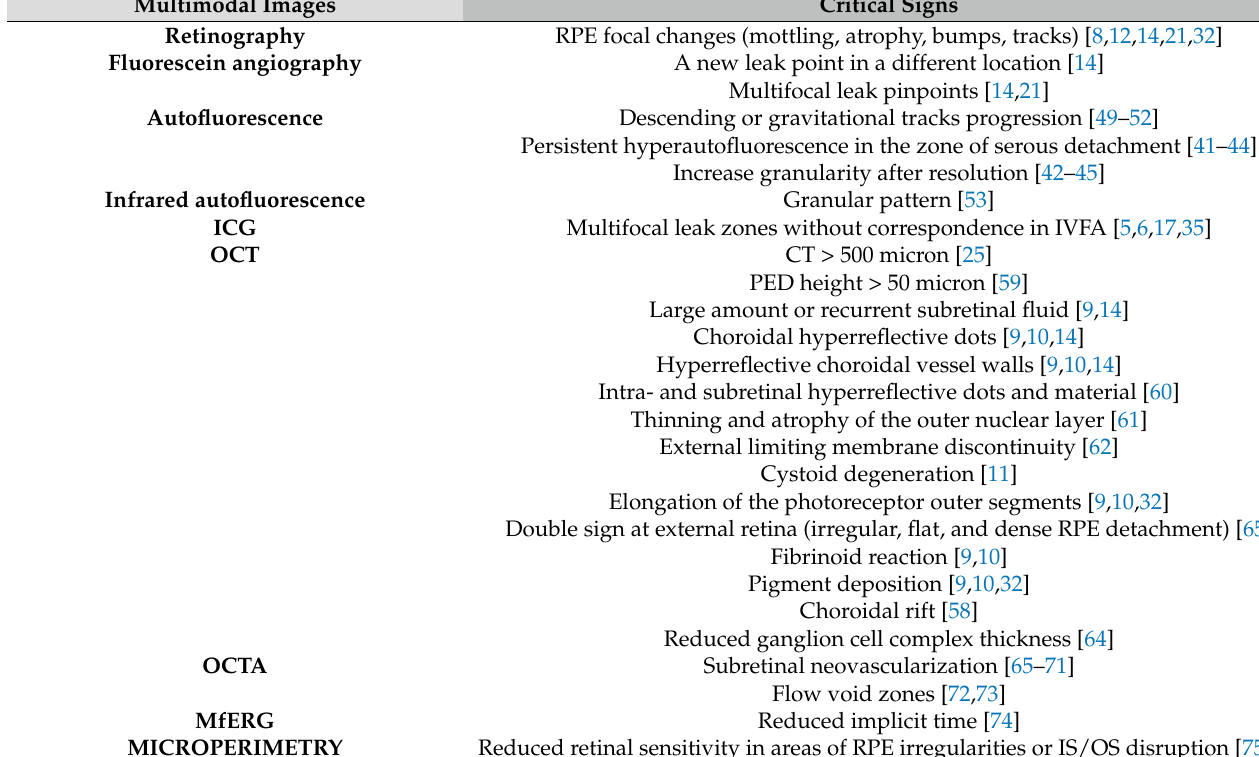
Table 1. Critical signs of central serous chorioretinopathy (CSC) in multimodal images. Multimodal